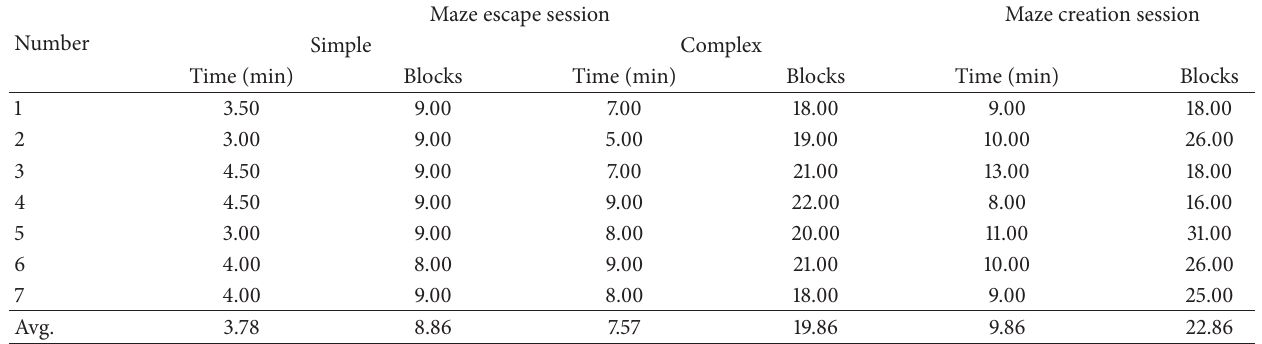
Table 1: The time (unit: minute) and blocks children used in the